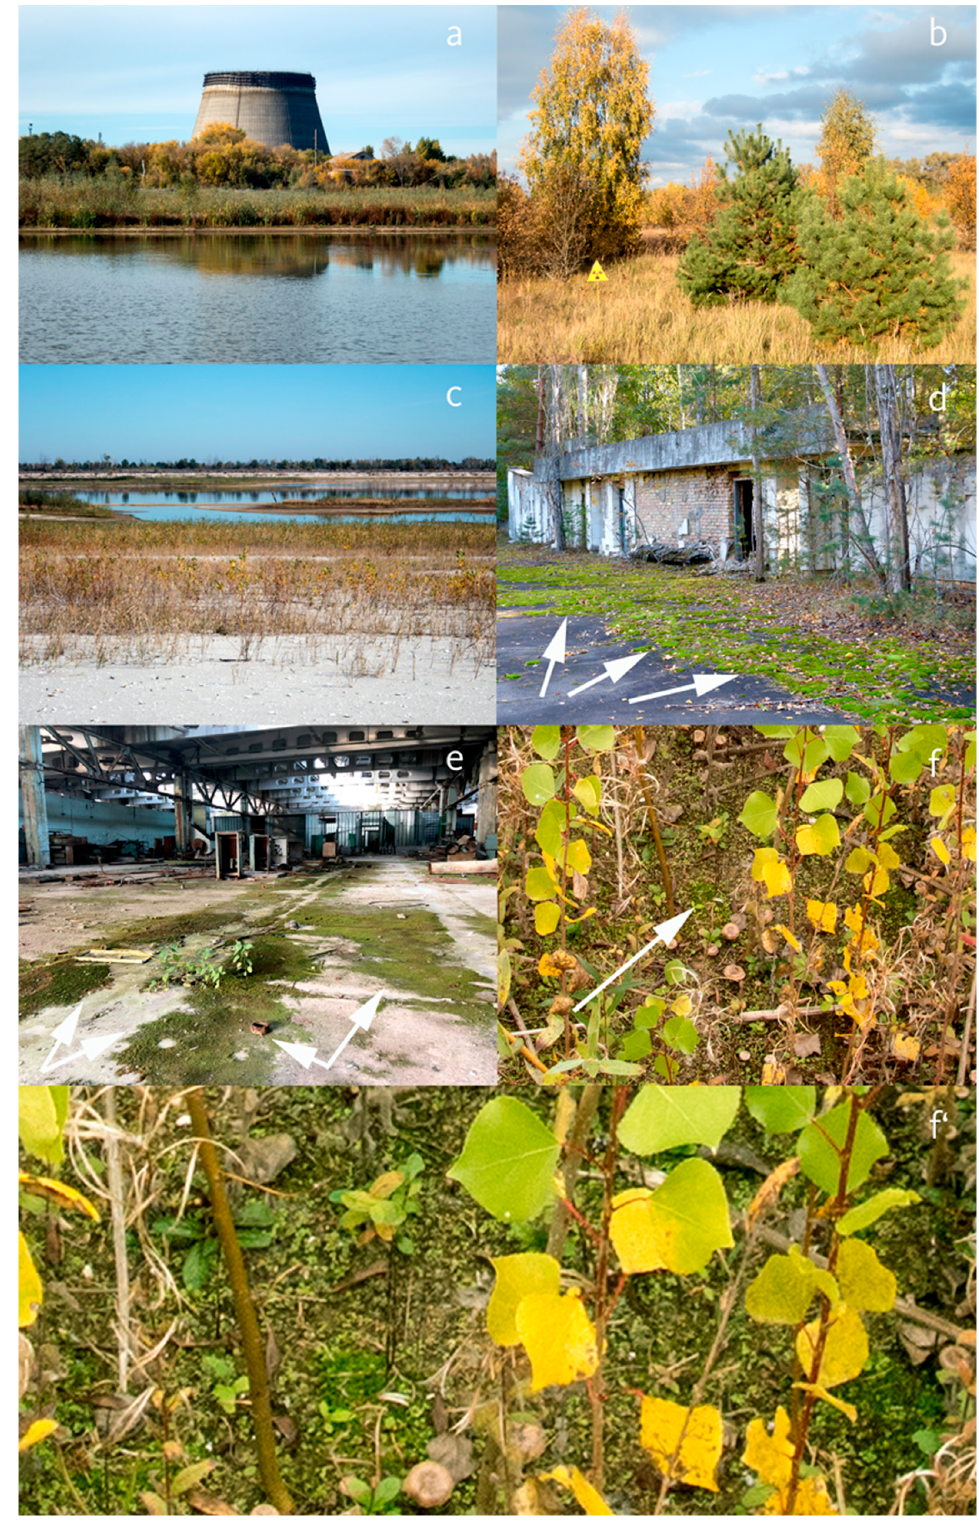
Figure 3. Selected sample sites. ( a ) Cooling pond with unfinished cooling tower, ( b ) dry meadow (#1–3), ( c ) bank of the cooling pond (#16,17), ( d ) Prypiat, moss cushions (#24), ( e ) decaying factory building in Prypiat with Amblystegium serpens covering concrete floor (#23), ( f ) Bryum moss cushion (#10–12), ( f’ ) detail of Bryum . Mosses indicated by white arrows.